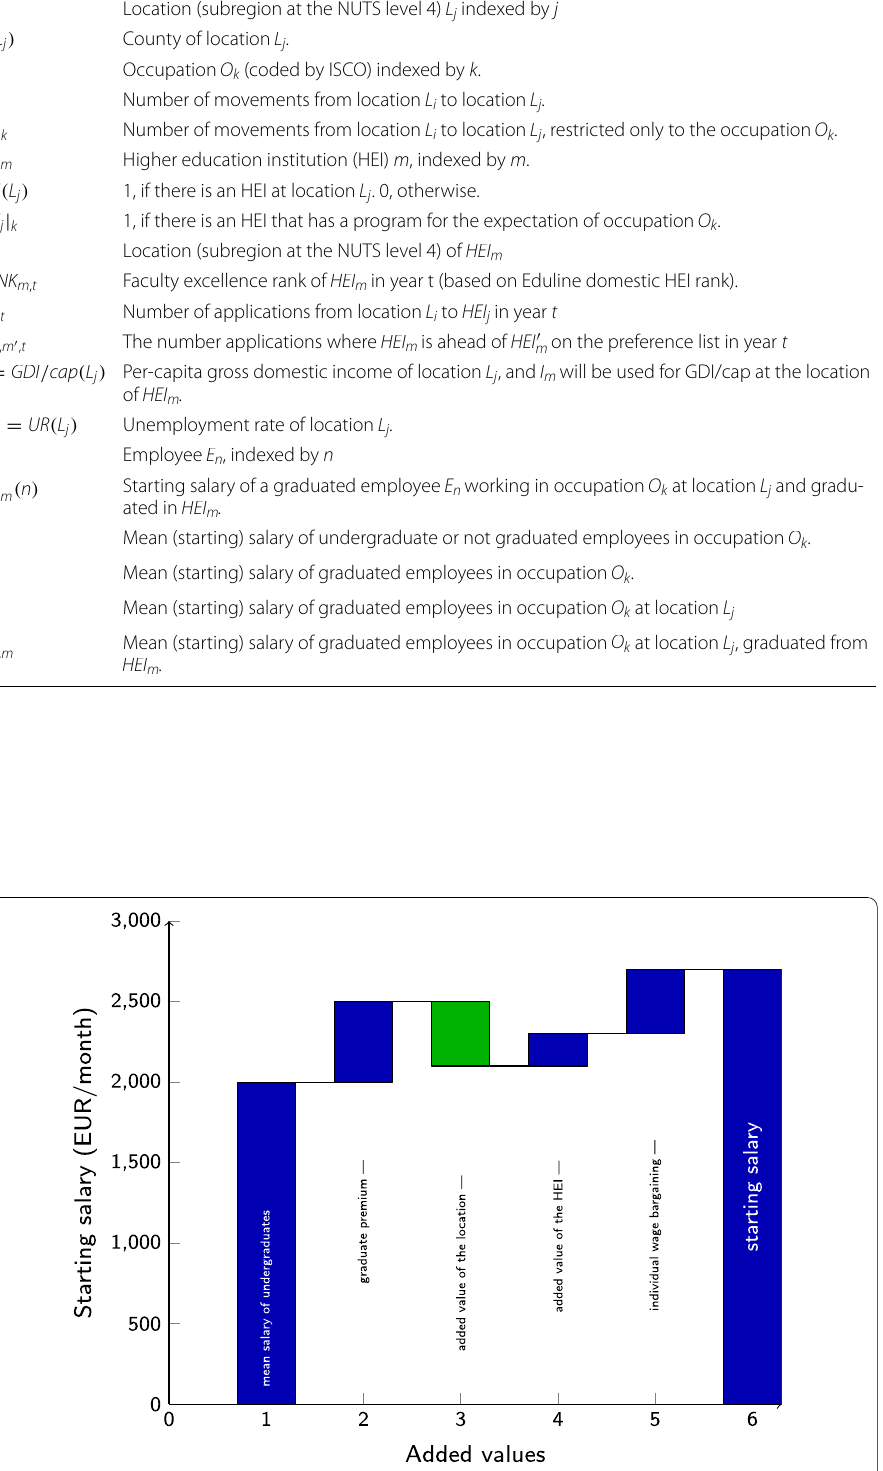
Fig. 2 An illustrative example of the added value of education and location to starting